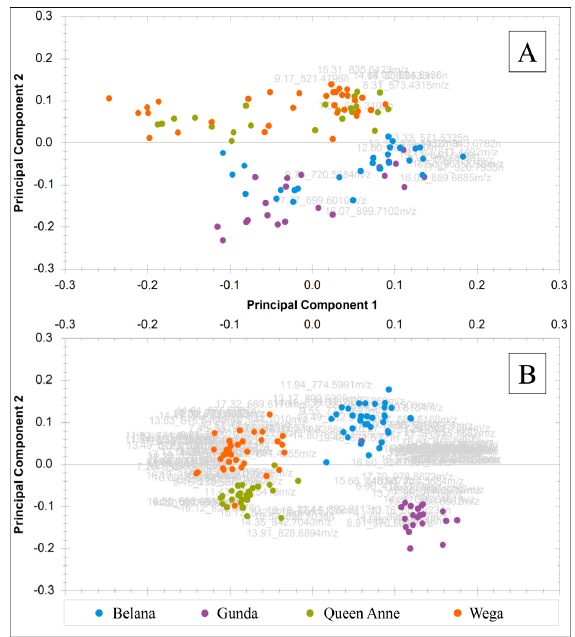
Figure 8. Combined principal component analysis (PCA) score and loading plots (bi-plots) of authentic potato samples displaying principal component 1 versus principal component 2: ( A ) samples extracted according to the Folch method using 19 filtered mass features with PC-1 36.07% and PC-2 23.95%; ( B ) samples extracted with EtOAc using 112 filtered mass features with PC-1 41.06% and PC-2 15.74%.